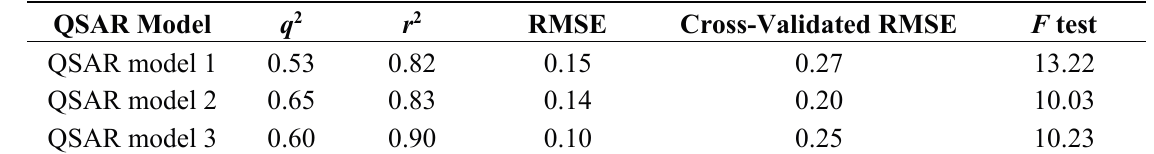
Table 1. Summary of quantitative structure-activity relationship (QSAR) statistical parameters for QSAR models 1–3: q 2 (cross-validated r 2 ), fitted correlation r 2 , root mean square error (RMSE), cross-validated RMSE and Fisher ( F ) test.